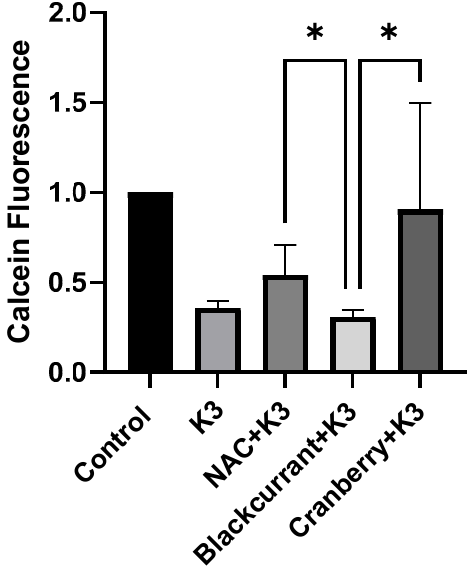
Figure 5. Effects of berry extracts (100 µg/mL) on cell viability in BV-2 cells. This figure demonstrates menadione (K3)-induced oxidative stress which decreased cell viability in comparison to the non- treatment group. As for treatment groups, cranberry extract+K3 and black currant (100 µg/mL) + K3 were nonsignificant for cell viability compared to K3 only. Although cranberry extract + K3 (100 µg/mL) did not show significance in cell viability compared to NAC+K3, it had the highest average cell viability among the other treatment groups. Due to the large standard deviation in one group, group means were compared by Welch’s ANOVA followed by Dunnett’s pairwise comparisons, and the only significant differences were between NAC and black currants (100 µg/mL) (* p = 0.0451) and between cranberry (100 µg/mL) and black currants (100 µg/mL) (* p = 0.0178).